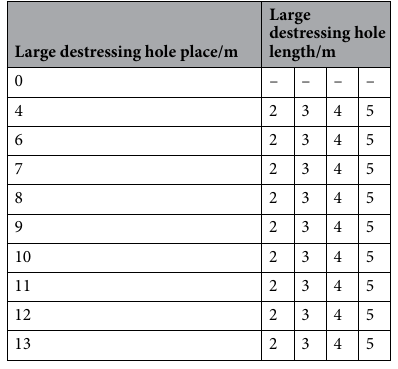
Table 3. Orthogonal numerical simulation scheme.